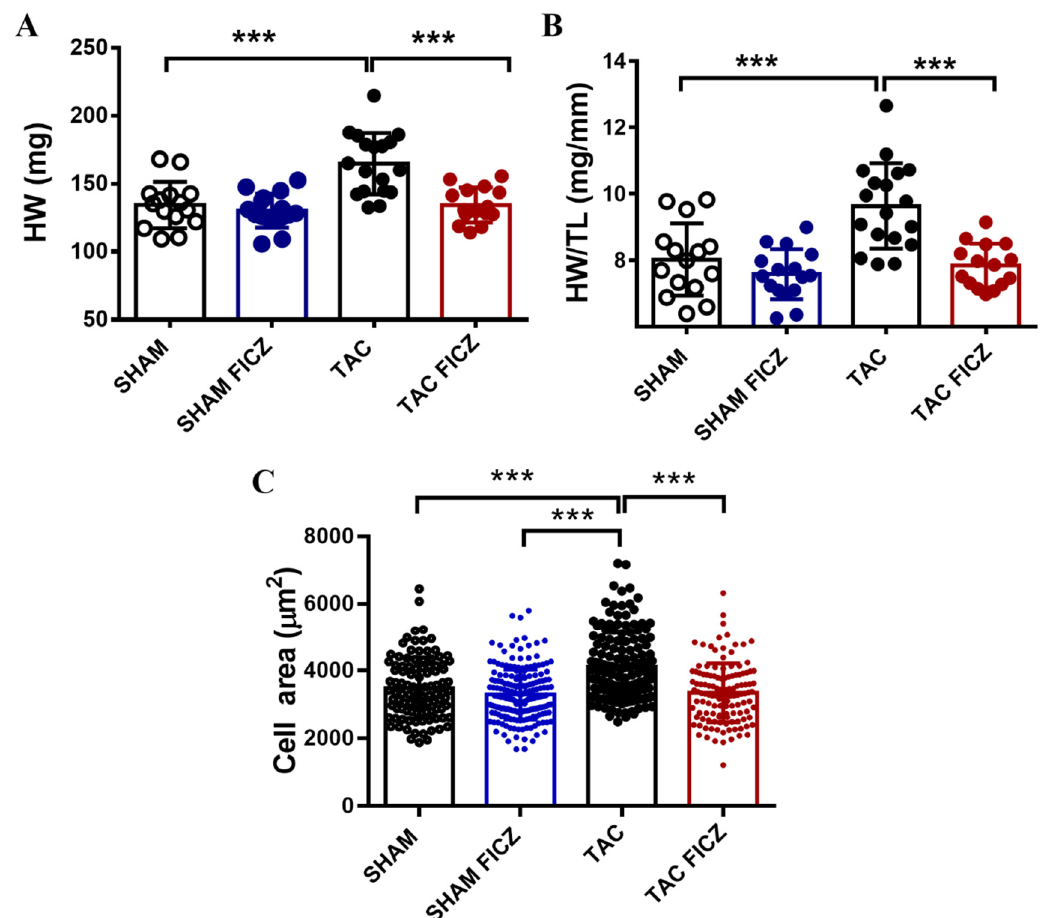
Figure 3. FICZ treatment prevents cardiac hypertrophy induced by TAC: ( A ). Heart weight (HW) (mg). ( B ). Heart Weight/Tibia Length HW/TL (mg/mm). Groups are: Sham (open circles) ( N = 15), Sham FICZ (blue circles) ( N = 16), TAC (black circles) ( N = 18) and TAC FICZ (red circles) ( N = 15). ( C ). Cardiomyocyte area ( µ m 2 ). Groups are: Sham (open circles) ( n = 106; N = 5), Sham FICZ (blue circles) ( n = 200; N = 4), TAC (black circles) ( n = 148; N = 5) and TAC FICZ (red circles) ( n = 126; N = 4). Data are expressed as mean ± SD. *** p < 0.001. N = number of mice; n = number of cardiomyocytes.